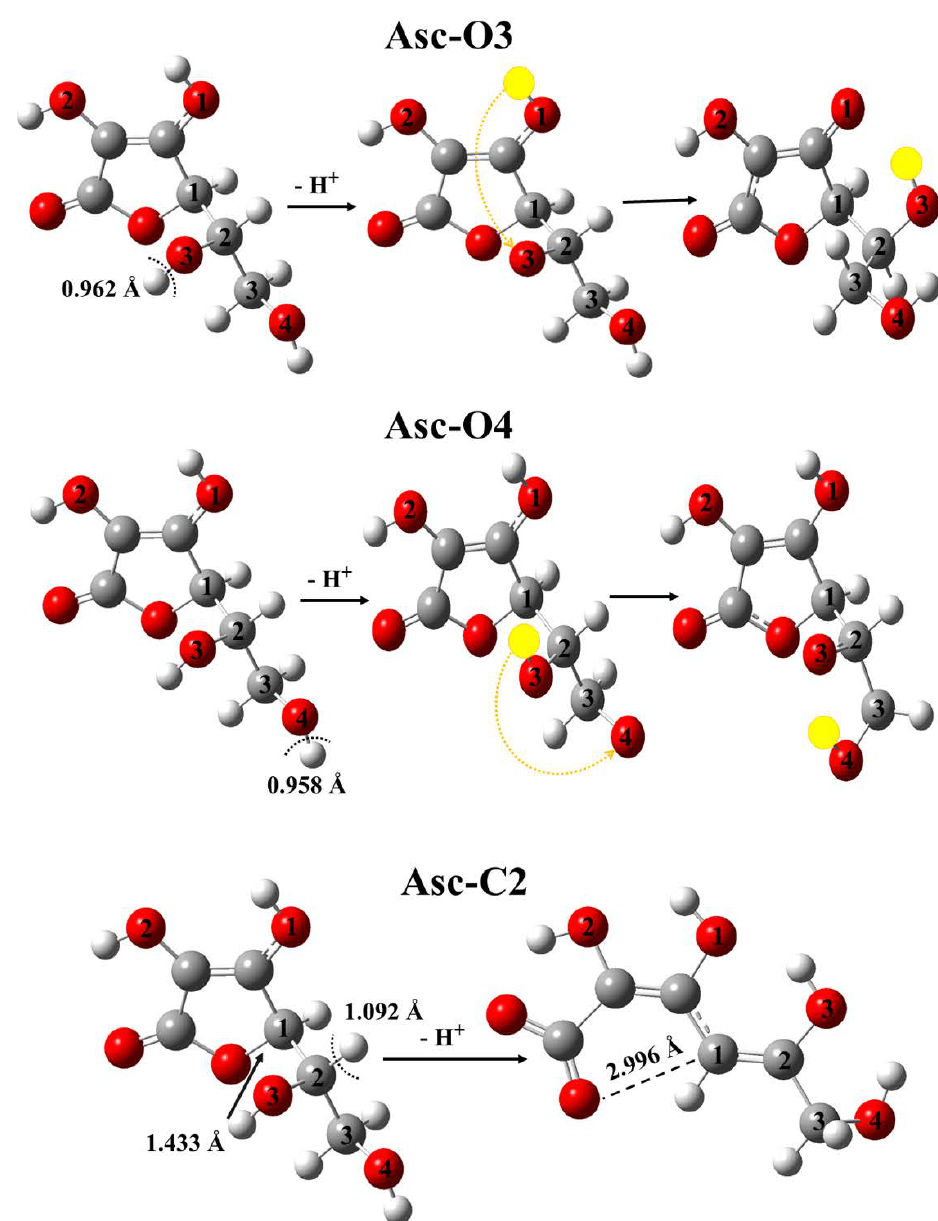
Figure 7. Optimized structures of ascorbic acid (Asc) and the corresponding anionic species after proton loss in the case of the O3-H, O4-H, and C2-H sites. The species have been computed at the M06-2X/6-311++G(2d,2p) level of theory in the gas phase and the corresponding bond lengths and distances (in Å) are also shown. Intramolecular proton transfers are indicated with orange arrows and the transferred protons are highlighted as yellow